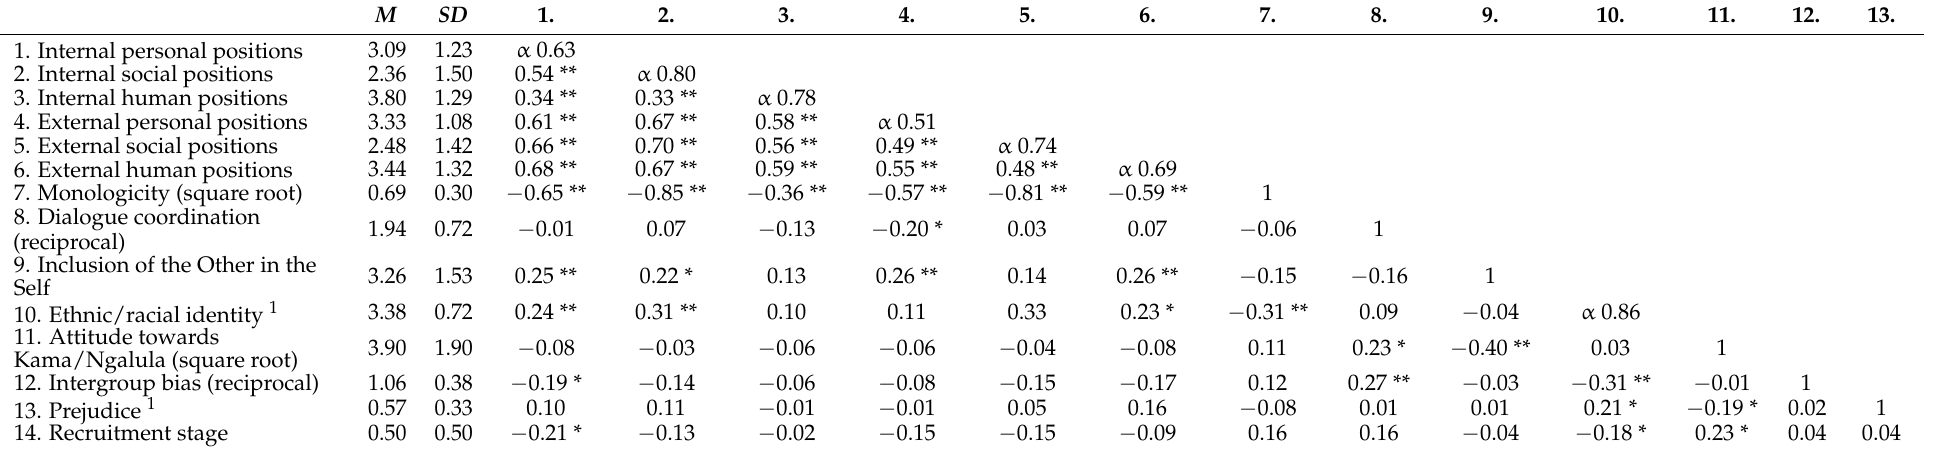
Table 2. Descriptive statistics and Pearson’s correlations among post-dialogue variables ( n =